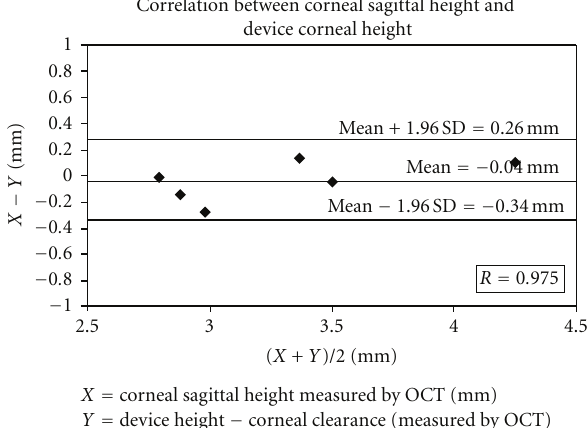
Figure 7: Bland-Altman plot of the correlation between OCT-measured corneal sagittal height and device corneal height.